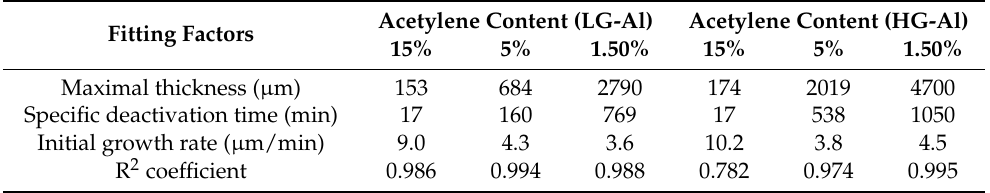
Table 2. Fitting factors obtained with Equation (3) and results obtained for various acetylene volume contents on: (left) LG-Al substrate, and (right) HG-Al